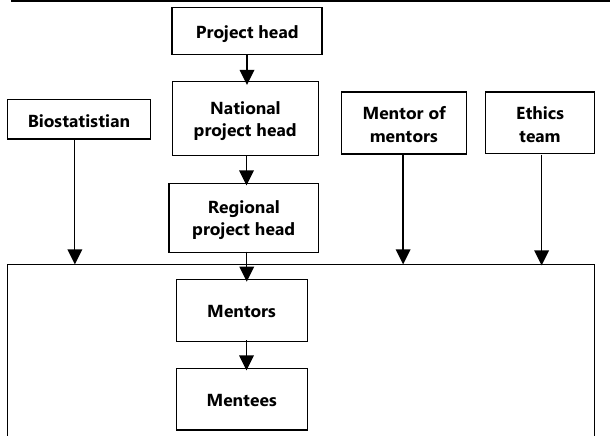
Figure 1 . Hierarchical Representation of the Members of Peer